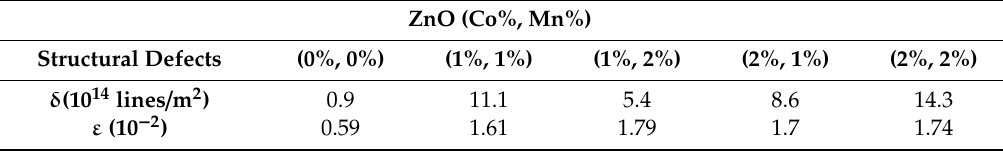
Table 3. Internal lattice strain ( ε ) of undoped and (Co, Mn) co-doped.